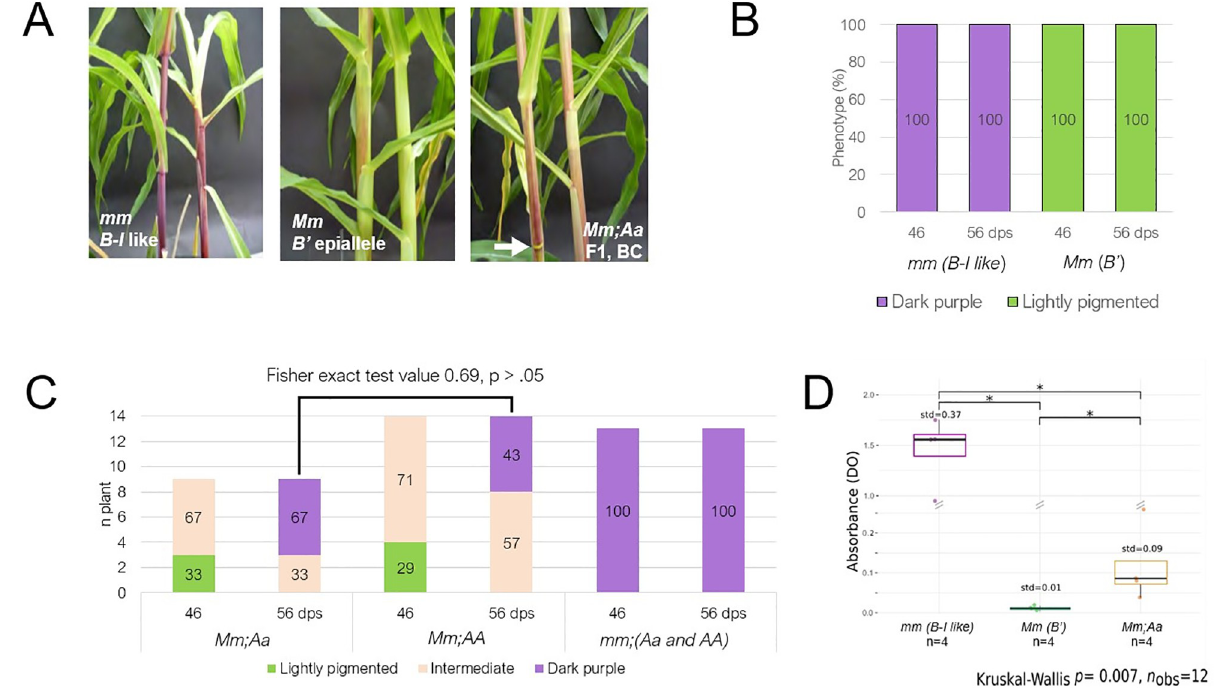
Fig 4. Pigmentation phenotypes observed at 46 and 56 days post seedling (dps). A ) Pictures of stem phenotypes at 46 dps in (left-to-right): mm control plants ( B-I like , dark purple pigmentation); Mm control plants ( B’ , light pigmentation); Mm;Aa cross 2 progenies (intermediate pigmentation). The white arrow indicates a typical unpigmented node. B and C ) Pigmentation phenotypes in control plants (with n > 25 for each control) and in cross 2 progenies, respectively. Numbers in bars are percentages. D) Absorbance at 550 nm of anthocyanins extracted using 1 g of stem tissue from 56 dps plants. std is the standard deviation. y axis scale is shown at .05 intervals between 0 < DO < 0.25 and 0.25 intervals between 1 < DO <